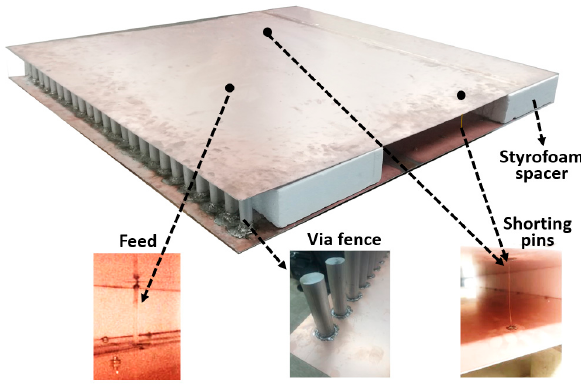
Figure 8. Simulated radiation patterns of the optimized antenna: ( a ) 3D and ( b ) 2D azimuth patterns.